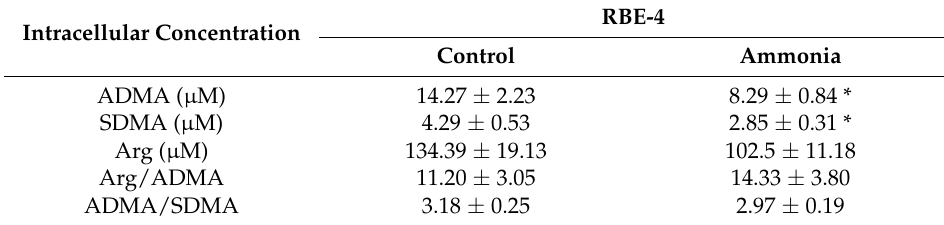
Table 3. The ADMA/SDMA/Arg concentration in (RBE-4) cells. Results are mean ± SD; n = 4; * p < 0.05 vs. control.